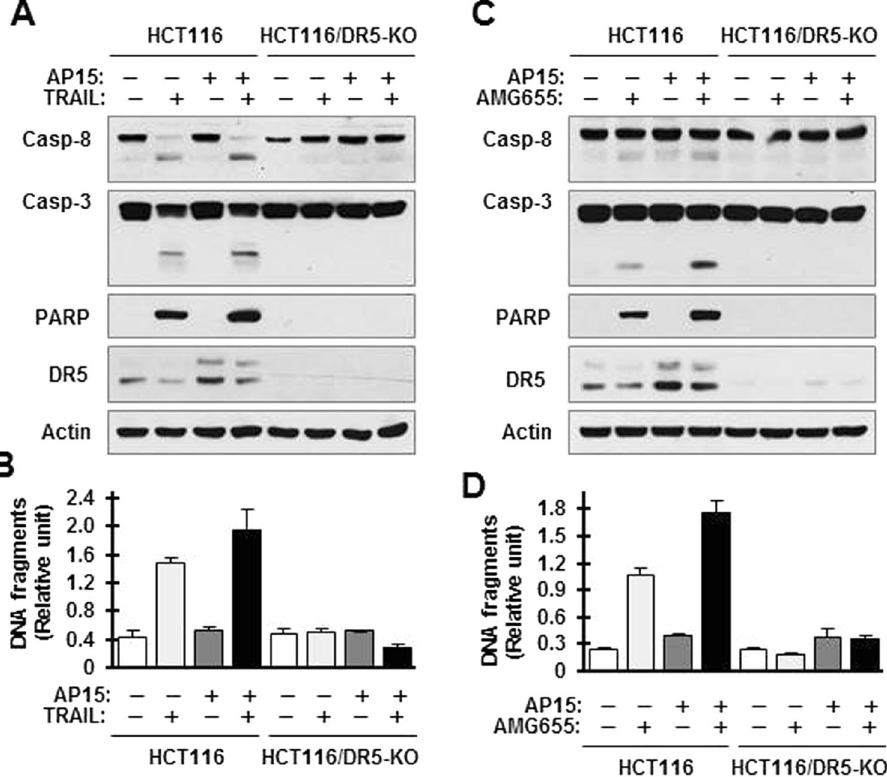
Figure 5. DR5 deficiency abolishes the enhanced induction of apoptosis by the combination of b-AP15 with TRAIL ( A and B ) or AMG655 ( C and D ). The indicated cell lines were pretreated with 0.5 μ M b-AP15 for 4 h and then co-treated with 20 ng/ml TRAIL ( A and B ) or 40 ng/ml AMG655 ( C and D ) for an additional 4 h. The cells were then harvested to measure DNA with a cell death ELISA kit ( B and D ) and to detect the cleavage of caspases and PARP with Western blotting ( A and C ). The data are means ± SDs of triplicate determinations. CF, cleaved fragment. Full-length blots/gels are presented in Supplementary Figure